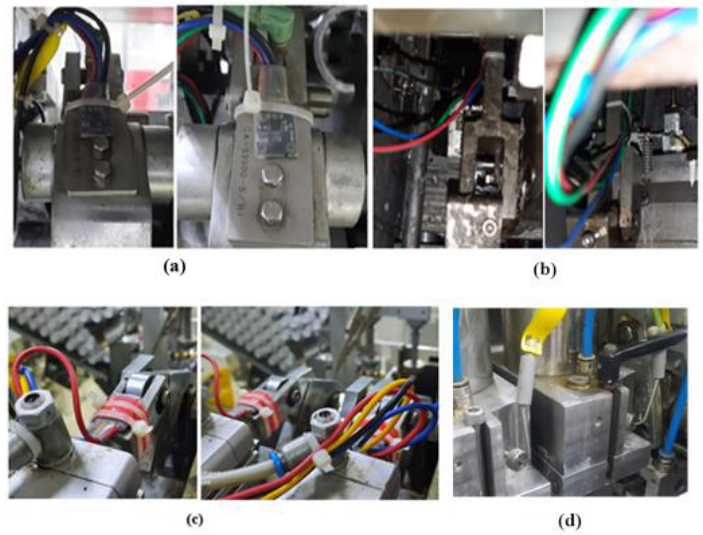
Figure 5. Actual sensor ’ s position in the machine ( a ) filling pump drive, ( b ) filling pump lever, ( c ) coding cam lever, and ( d ) hot air station, thermocouple.